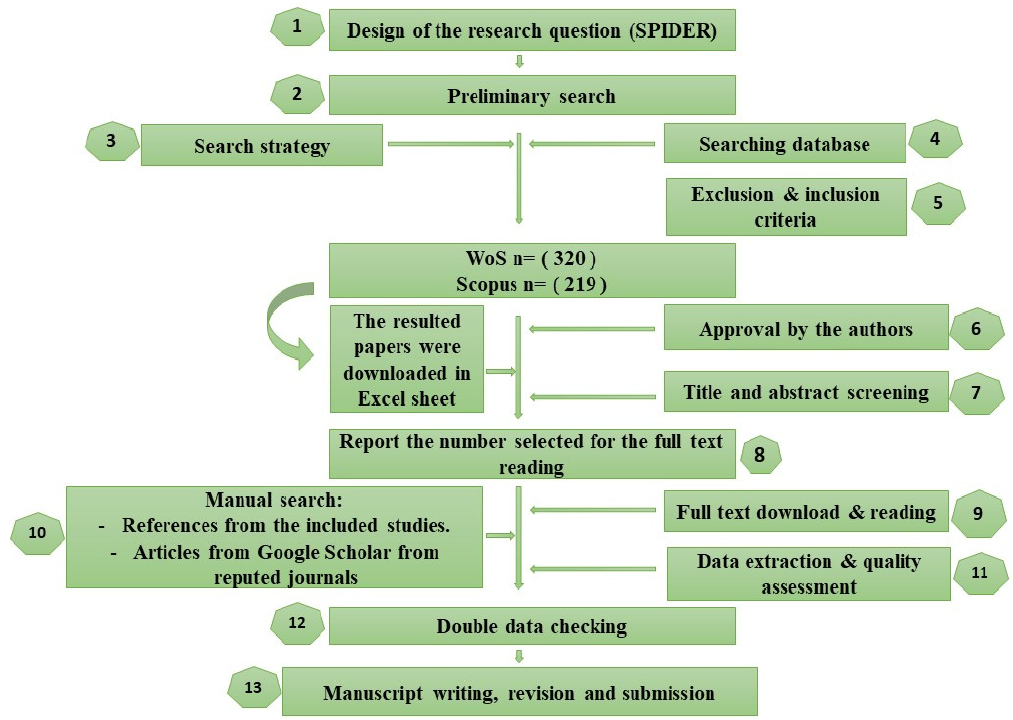
Figure 1. PRISMA tool and steps involved in this review .